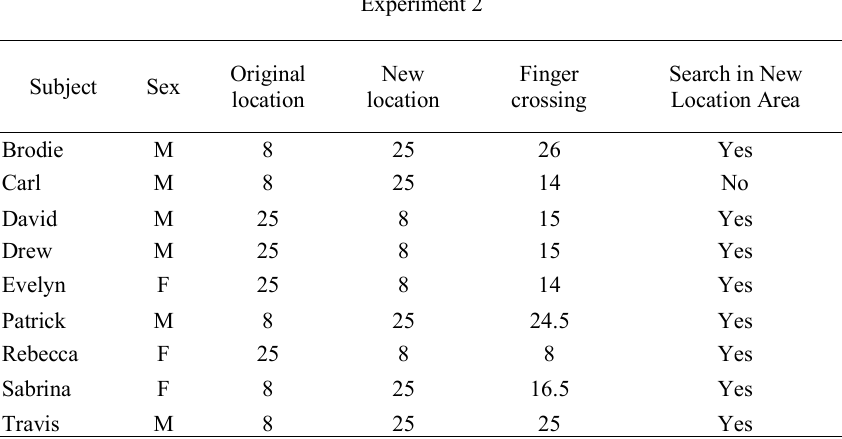
Dataset for Experiment